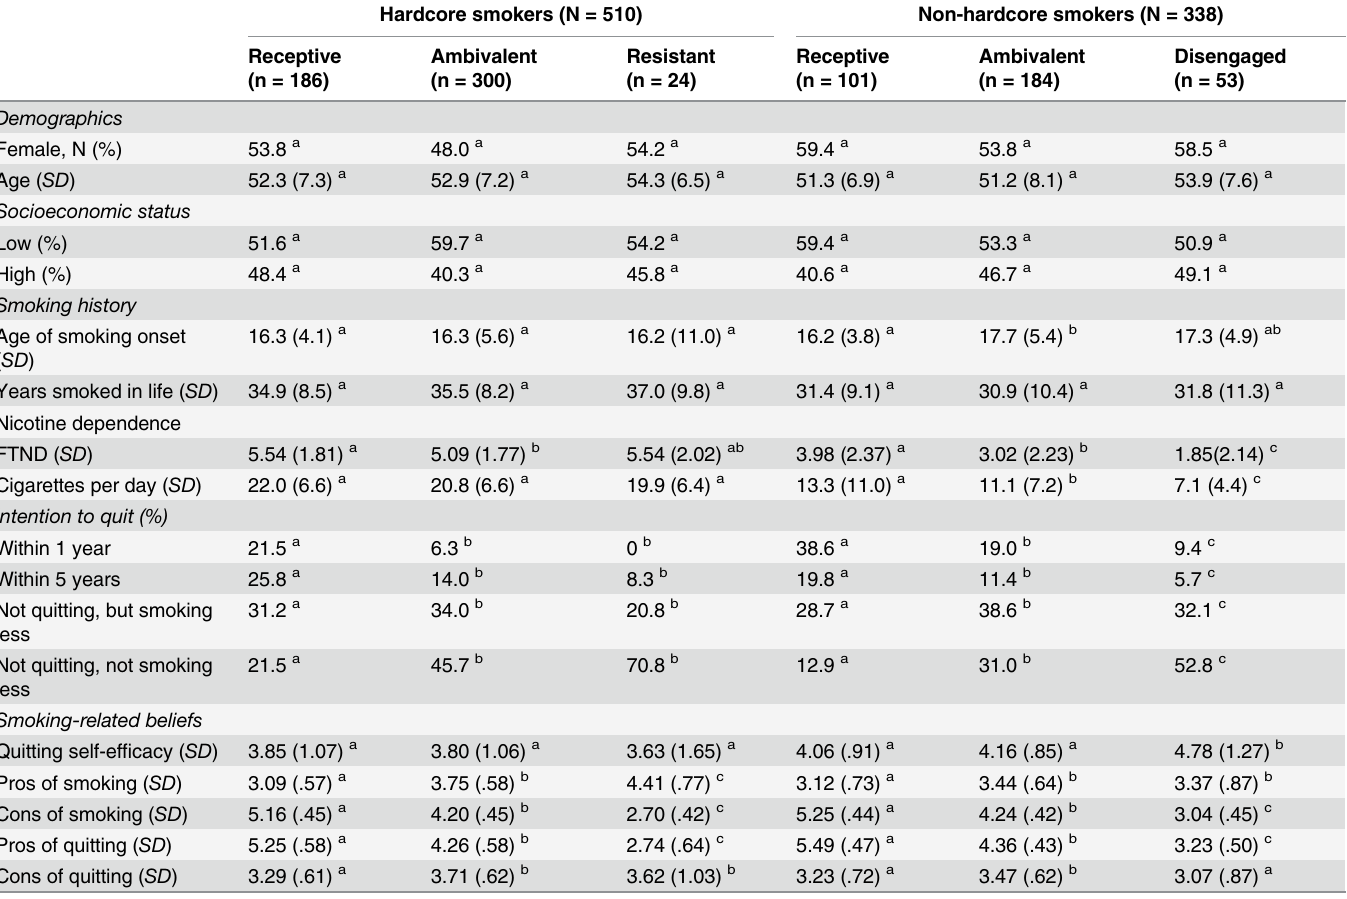
Table 3. Characteristics of profiles in hardcore smokers and non-hardcore smokers.